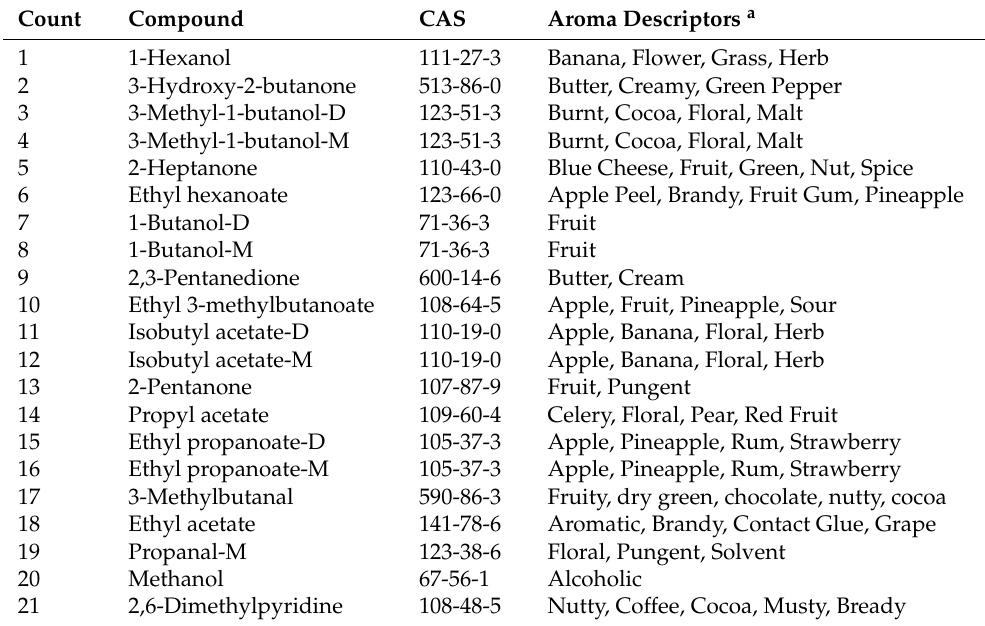
Figure 4. ( a ) Partial least squares Discriminant Analysis (PLS-DA) plot of different groups of jujube liquor; ( b ) loading plot of different groups of jujube liquor; ( c ) VIP plot of different groups of jujube liquor. ( S. cerevisiae -‘SC’, S. cerevisiae and Lactobacillus -‘SC.L’, S. cerevisiae , and P. pastoris -‘SC.PP’, Table 3. Volatile compounds with VIP > 1.